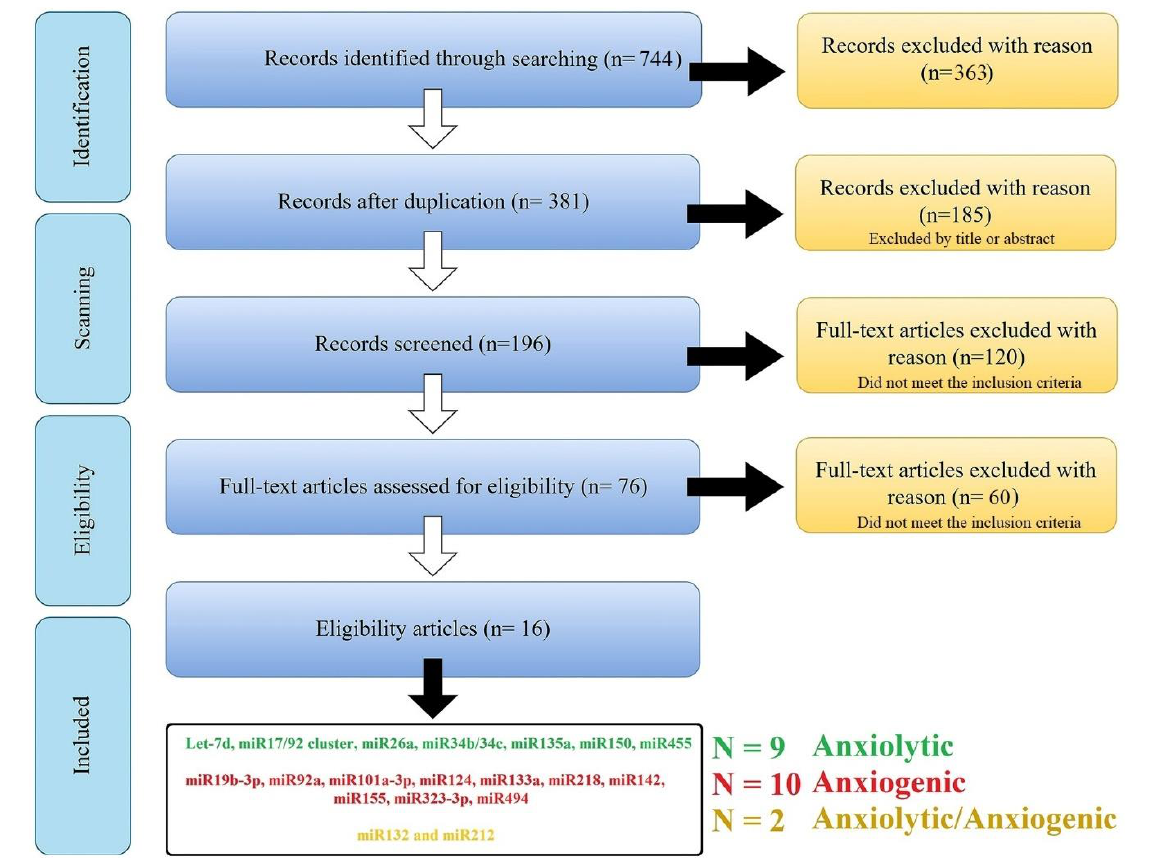
Figure 1. An overview of searching and scanning articles according to the PRISMA. The search of the PubMed, Scopus, and Web of Science databases provided 744 citations. Of these, 363 studies were removed after filtering out the duplicates, and of those, 185 studies were discarded after reviewing the titles. After adjusting for abstracts that did not meet the criteria, 196 articles remained. Finally, the full text of the remaining 196 citations was examined in more detail, and 120 studies in the first step and 60 in the second did not meet the inclusion criteria described. After the comprehensive screening, we reach twenty-one miRs from sixteen